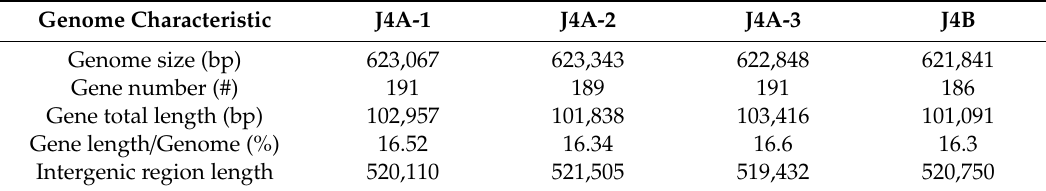
Table 1. The assembled features of the mt